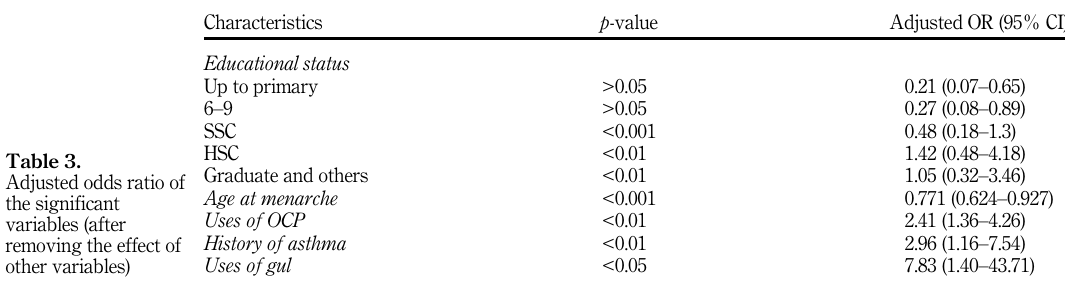
Table 2. Uses of oral contraceptives pills